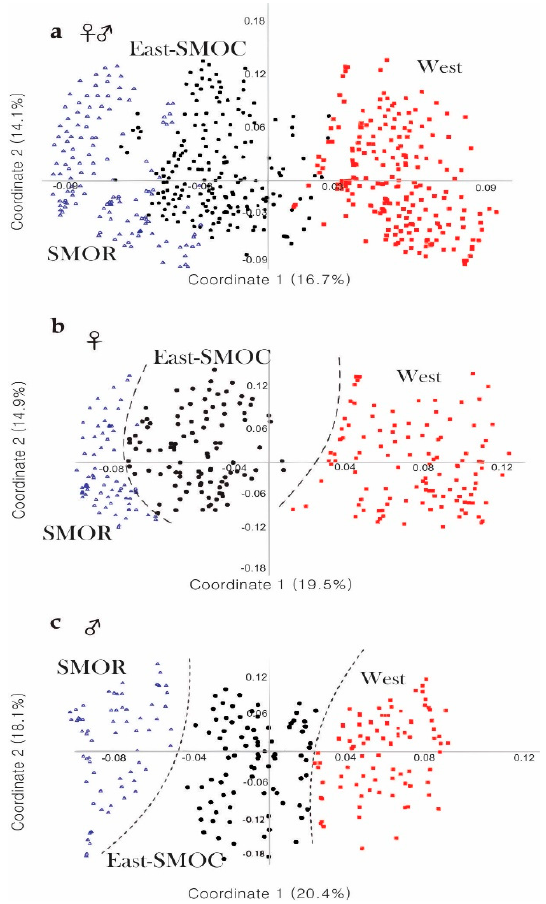
Figure 4. Scatters plots from principal coordinate analysis (PCoA) from qualitative and quantitative characters in D . brevicomis populations. ( a ) Among specimens of both sexes, ( b ) among females, and ( c ) among males.